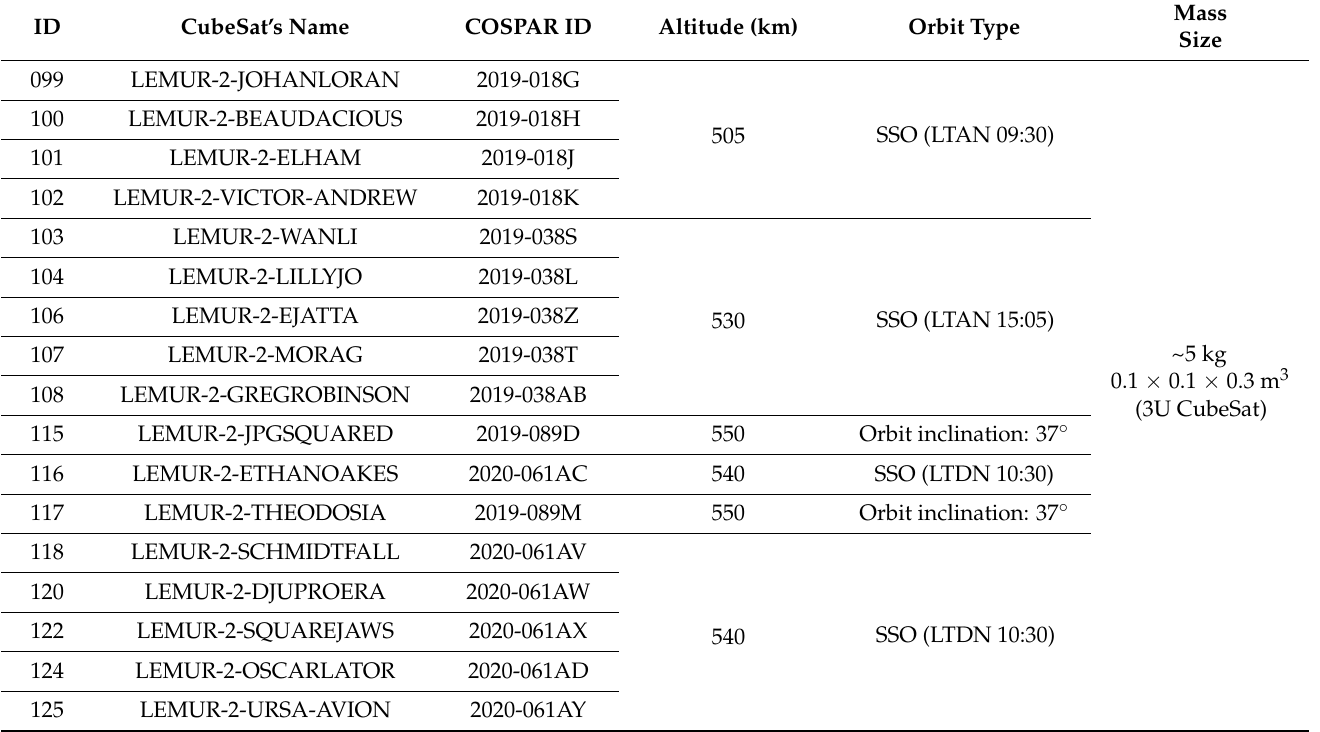
Table 2. Specifications of seventeen CubeSats employed in this study. SSO: Sun-Synchronous Orbit, LTAN: Local Time of Ascending Node, LTDN: Local Time of Descending Node (provided by Spire Global